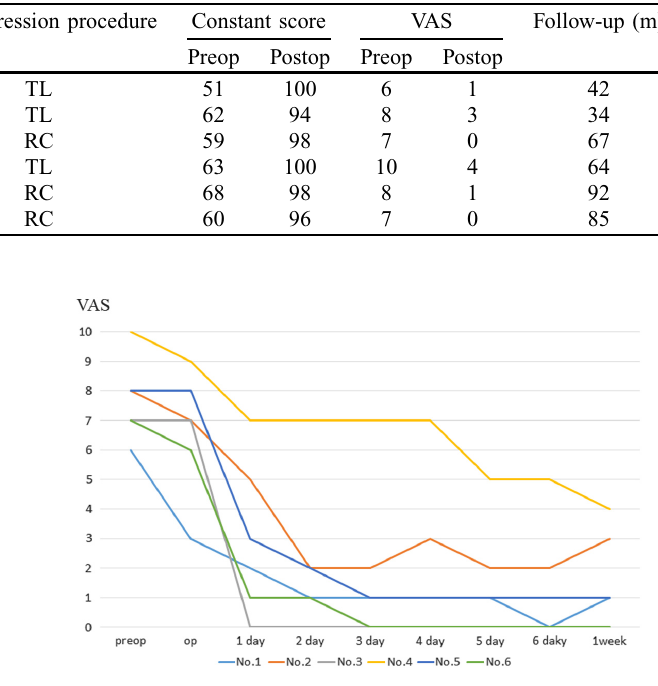
Figure 5. The VAS score of the three patient (no. 3, 5, 6) treated by decompression of the cyst through the released capsule decreased earlier than those through the torn